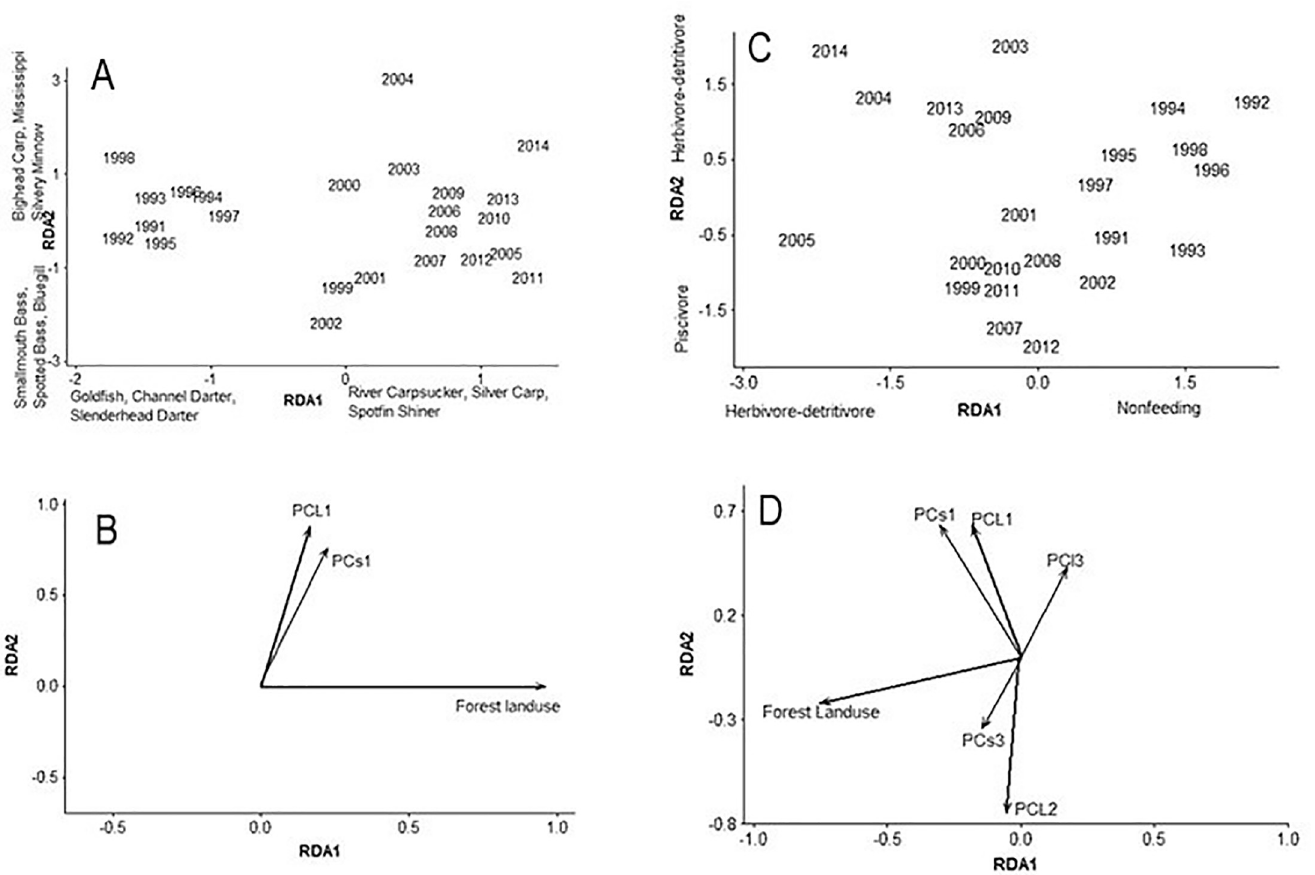
Fig 4. Redundancy analysis using taxonomic counts from electrofishing collections, with significant environmental vectors on bottom (A, B). Axes explained 22.4% and 6.4% of variation. PC axes represent altered hydrology variables (loadings are in Table 2). Species or trophic traits with highest loadings on axes are listed. Redundancy analysis using trophic counts from electrofishing collections, with significant environmental vectors on bottom (C, D). Axes explained 25.6% and 13.2% of variation. PC axes represent altered hydrology variables. Species or trophic traits with highest loadings are listed on axes.